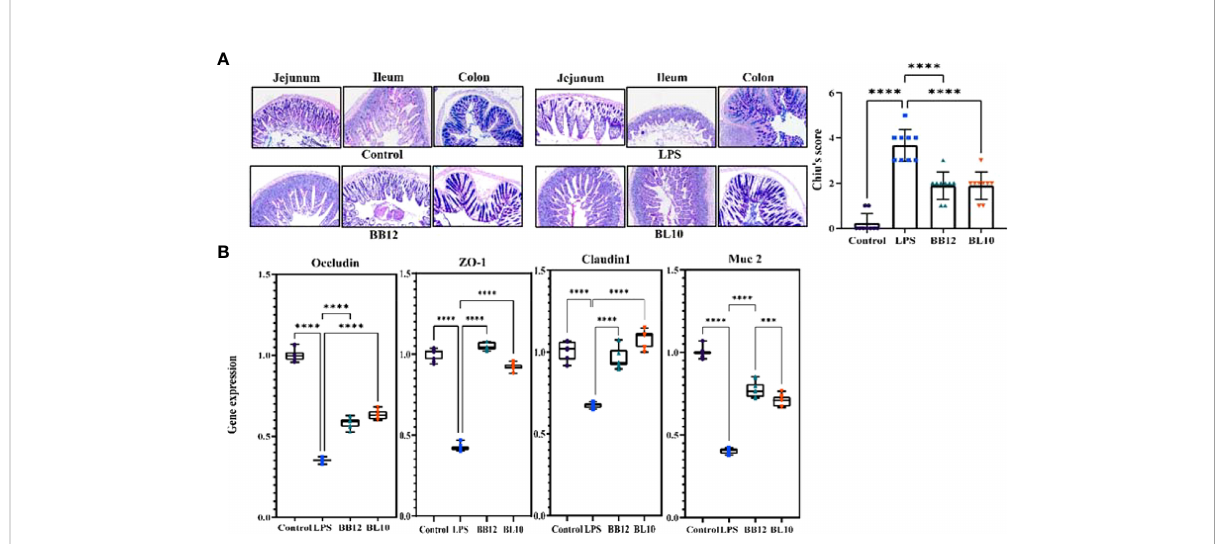
FIGURE 3 Effect of B longum BL-10 on LPS-induced intestinal barrier protection. (A) AB-PAS staining (magni fi cation × 200); (B) Tight junction protein mRNA expression. All data are expressed as mean ± SD (n=10). Values with a different superscript letter (*** and ****) were signi fi cantly different at p < 0.001 and p <